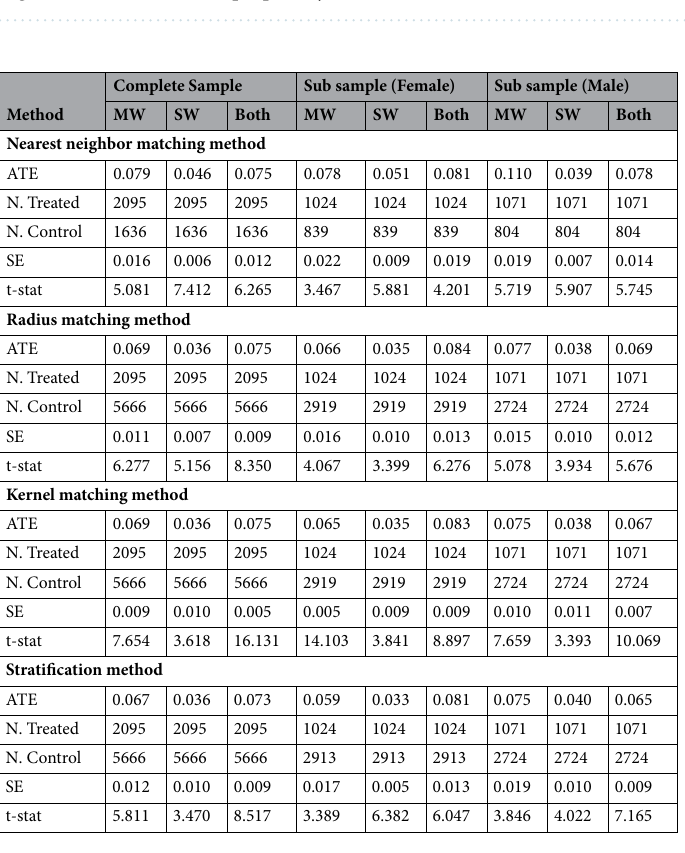
Figure 1. Distribution of propensity scores between treated (LBW) and untreated groups (NBW).